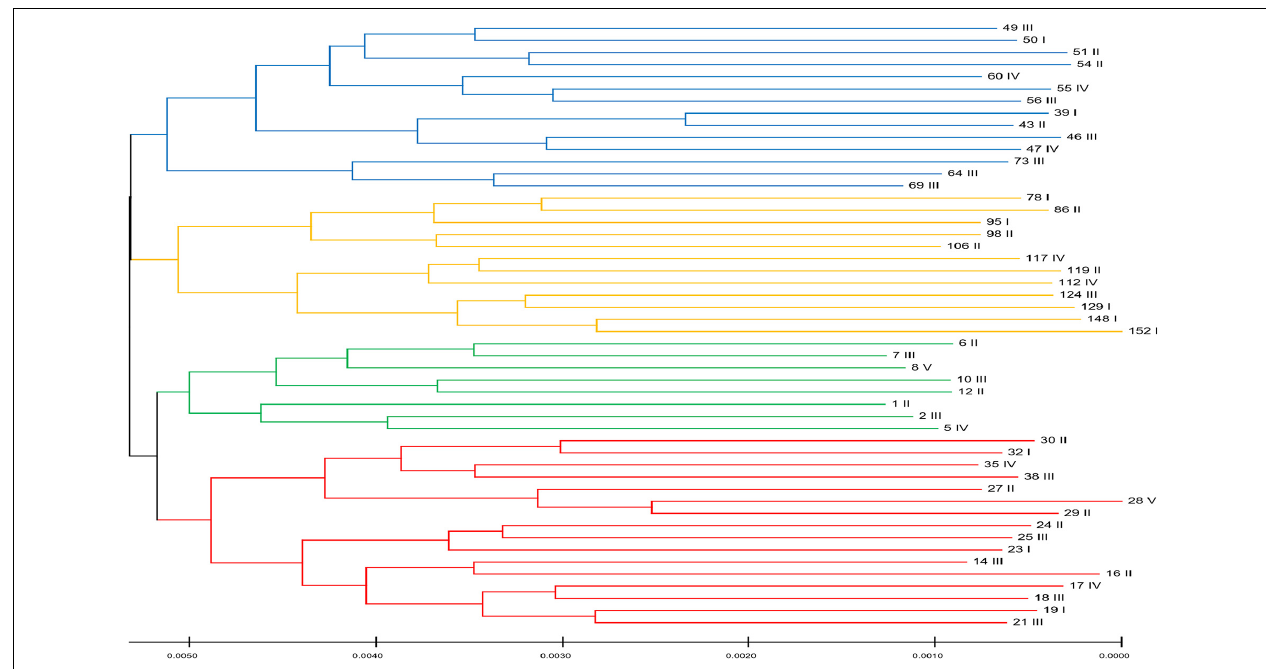
FIGURE 2 | The structure of the population for this Portuguese oyster population in the first generation. Colors represent four distinct clusters based on genetic similarities. Roman numerals represent the whole weight category that the individual belong to: I: 30–40, II: 40–50, III: 50–60, IV: 60–70, and V: > 70 g. This figure demonstrates that the oysters in the population do not cluster based on their whole-body weight but only based on their genetic